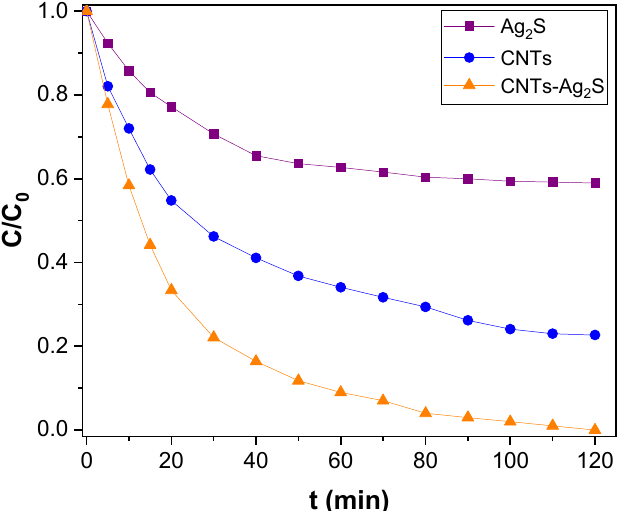
Figure 12. The degradation of alizarin yellow R in the presence of CNTs, Ag 2 S, and CNTs-Ag 2 S under the illumination to sunlight.